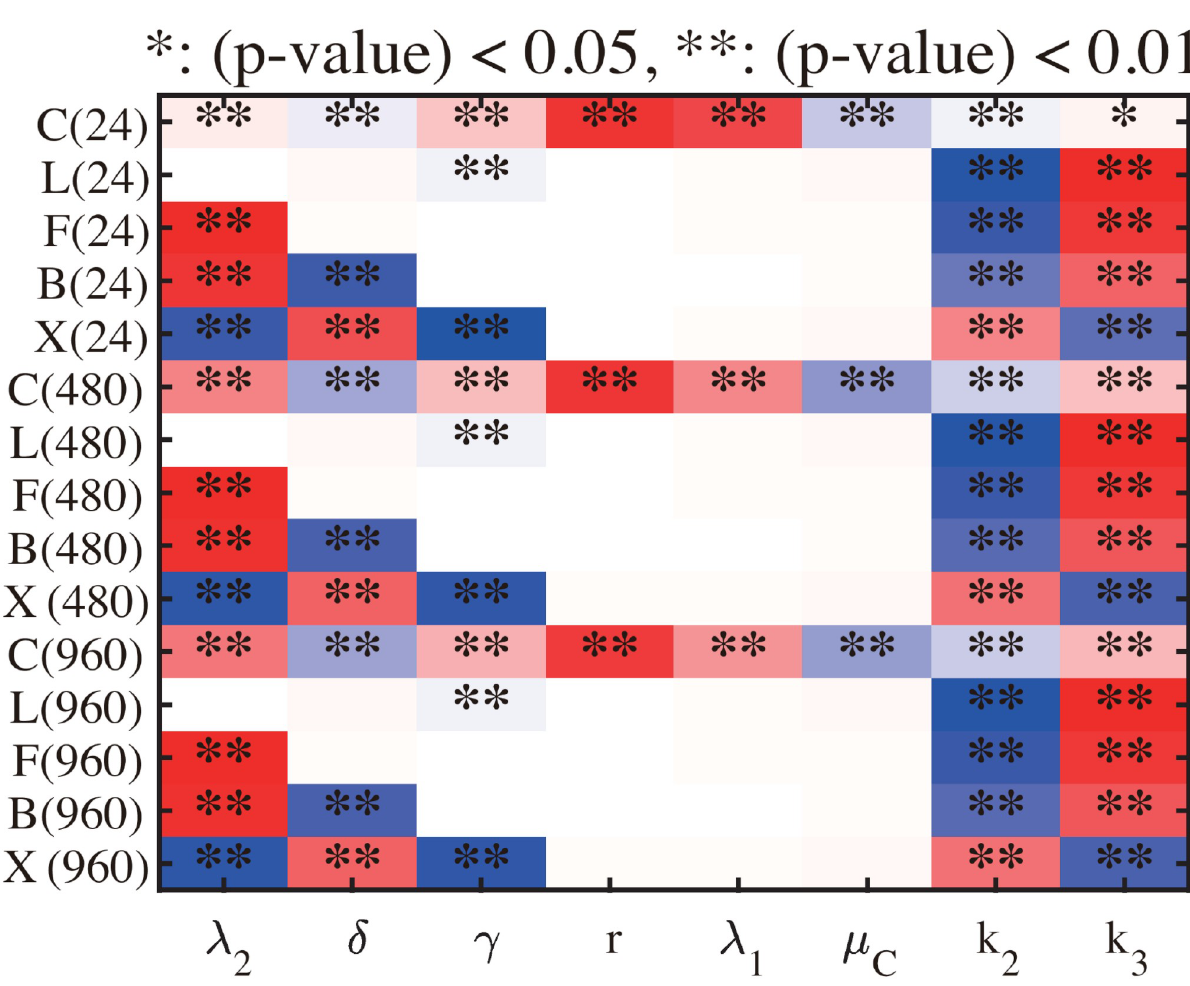
Fig 11. Sensitivity analysis. General Latin Hypercube Sampling (LHS) scheme and Partial Rank Correlation Coefficient (PRCC) were used for the mathematical model. The reference output in color is PRCC values (red for positive PRCC values; blue for negative PRCC values) for the density of tumor cells ( C ), concentration of IL-6 ( L ), NF- κ B ( F ), Bcl-2 ( B ), and BAX ( X ) at time t = 24, 480, 960 h . Analysis was carried out using the method of [67] with a sample size